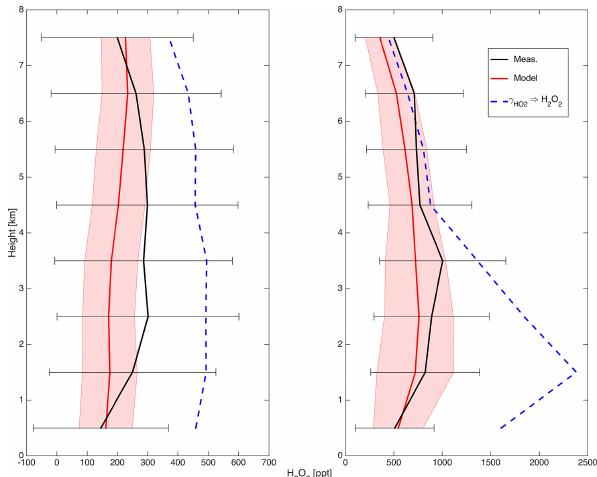
Figure 11. Vertical profile for H 2 O 2 for flights during ARCTAS-A (left) and ARCTAS-B (right). Shaded region represents 1 σ of model ensemble. Error bars represent measurement uncertainty. Blue lines show gamma HO 2 producing H 2 O 2 rather than H 2 O in the